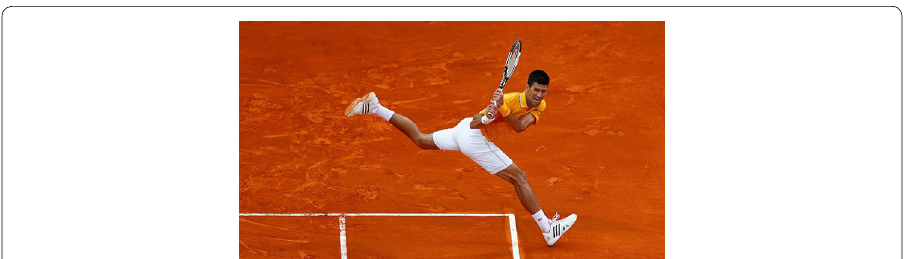
Fig. 5 Novak Djokovic (reproduced in Robson 2015)